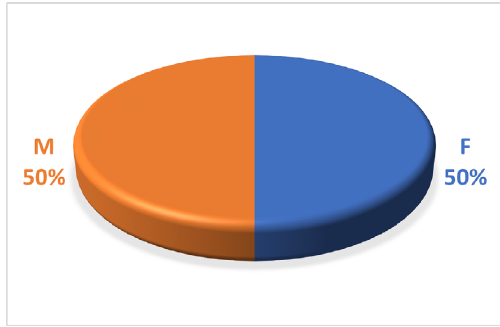
Figure 1. Distribution of male and female prediabetic individuals. M: male; F: